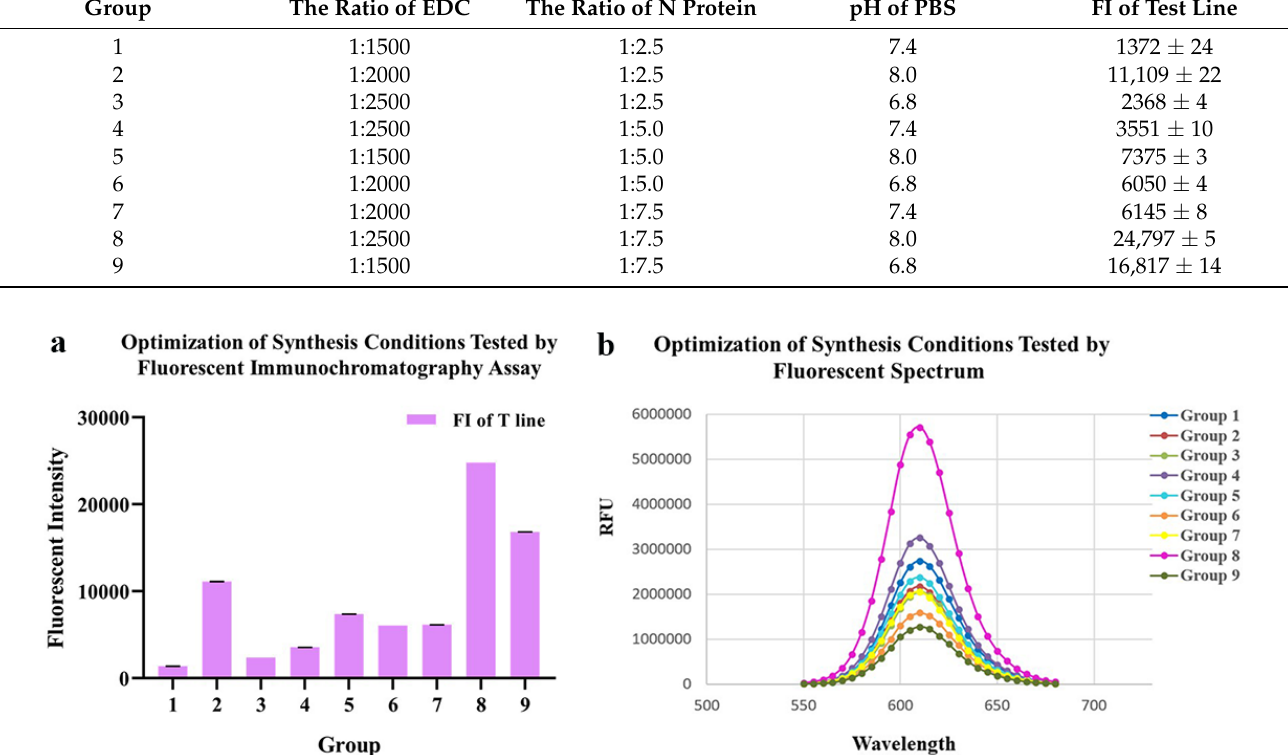
Figure 2. Optimization of conjugating conditions of QDs-N probes. ( a ) Fluorescent intensity of 9 probes synthesized with different conditions tested by fluoro-immunoassay. ( b ) Fluorescent Spec- trum of 9 probes, which indicated that the conjugation 8 presented the best fluorescent performance.